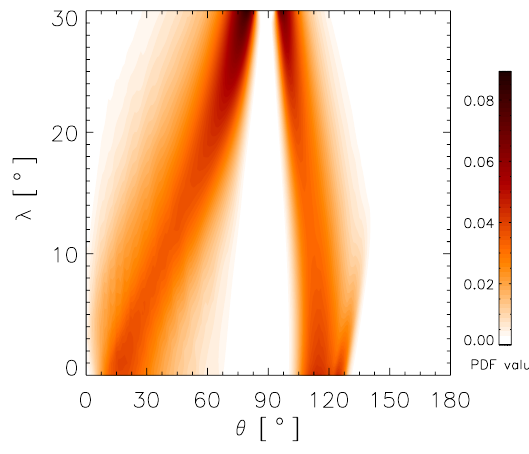
Fig. 2. The PDF of the wave-vector angle θ distribution (x-axis) as a function of magnetic latitude (y-axis) for all computed rays, using Eq. (1) as initial weight